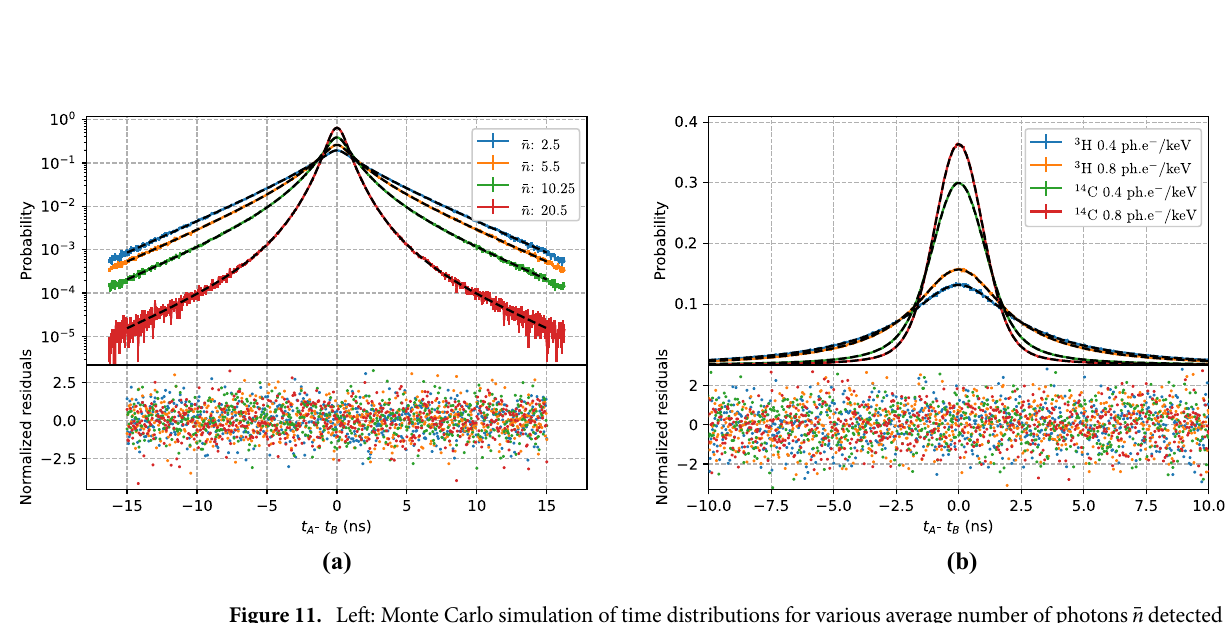
Figure 11. Left: Monte Carlo simulation of time distributions for various average number of photons by two PMTs and the time distributions calculated using Eq. (28) for the same parameters σ , (cid:31) and ε . Right: Monte Carlo simulation of time distributions for